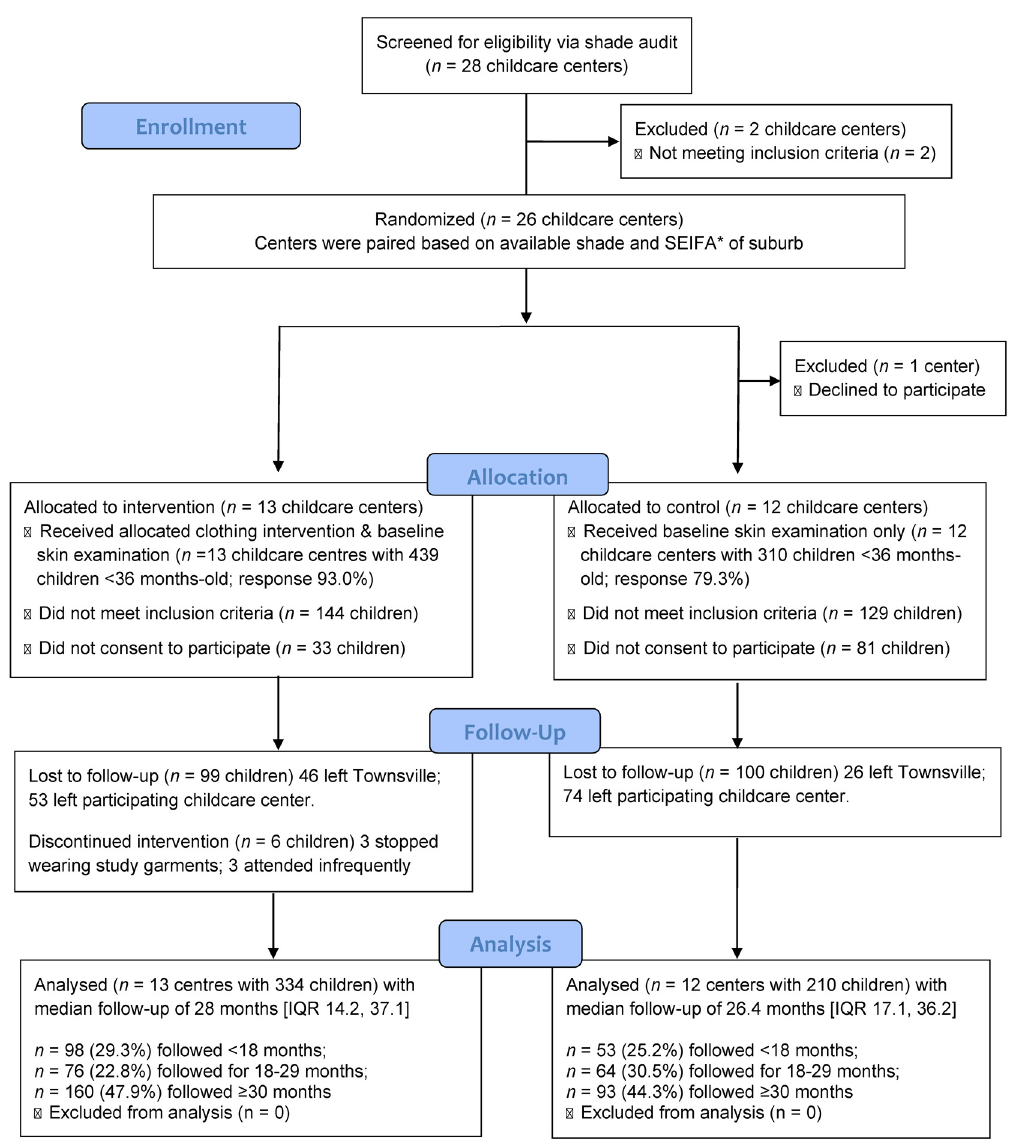
Figure 1. CONSORT 2010 flow diagram [57] showing 1–35-month-old children from Townsville, Australia, who were randomized by childcare center (clusters) to parallel arms of this cluster randomized controlled trial for up to 4 years. Abbreviations: SEIFA, socioeconomic index for areas [55]; n = number; < less than; ≥ greater than or equal to.